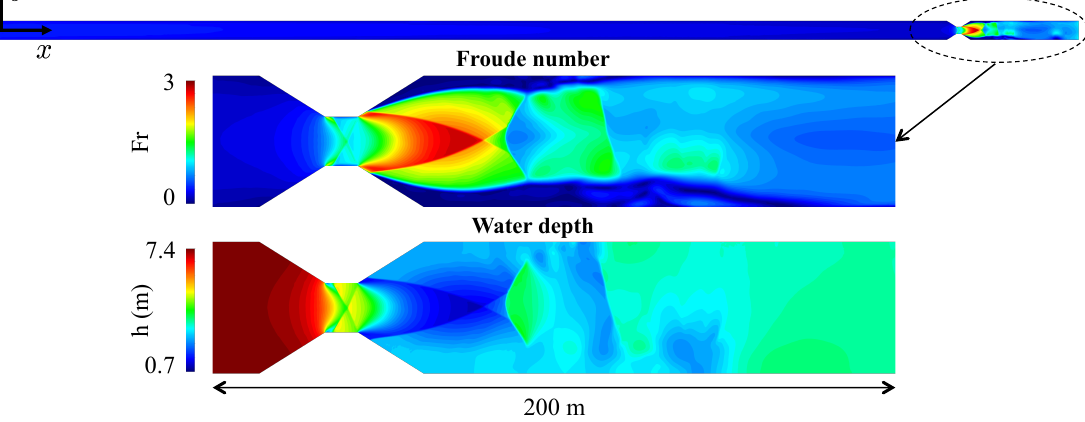
Figure 1. We study free surface flow in long channels, where tranquil flow under mild slope conditions is altered by a symmetric contraction. Depending on channel geometry and flow parameters, the contraction may induce a transition from subcritical to supercritical regime at the narrowest throat, and then back to subcritical flow downstream of it. Transcritical flow is revealed by distinctive two-dimensional flow patterns, both in terms of water surface morphology and spatial structure of the velocity field. Typical flow features associated with transcritical flow past a contraction include oblique standing waves and flow separation that disturb the flow over long distances, promoting flow focusing, the appearance of stagnation regions and the loss of flow